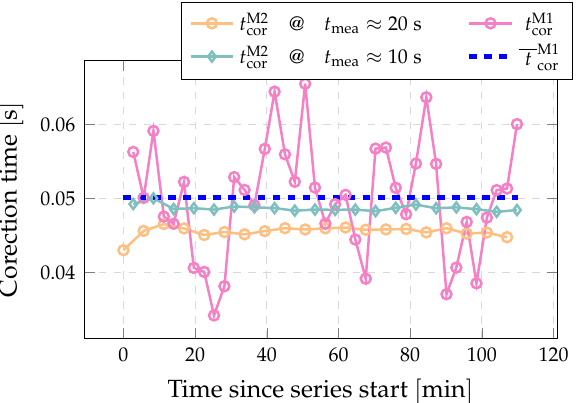
Figure 8. Example of consecutively measured correction time with two methods. Blue lines represent average of presented Method 1 results. ( t II → I